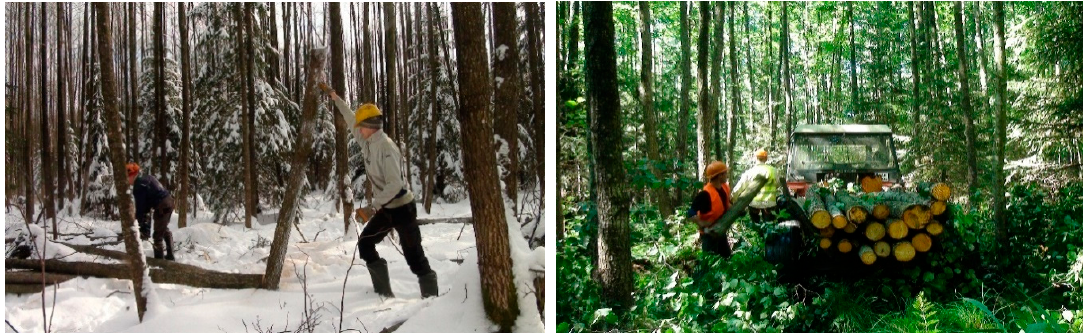
Figure 1. View of the studied black alder stands and logging operations. Photo by W. Grzywi´nski. A total of 24 sample plots were selected. Each plot was a square with side 50 m (area 0.25 ha).